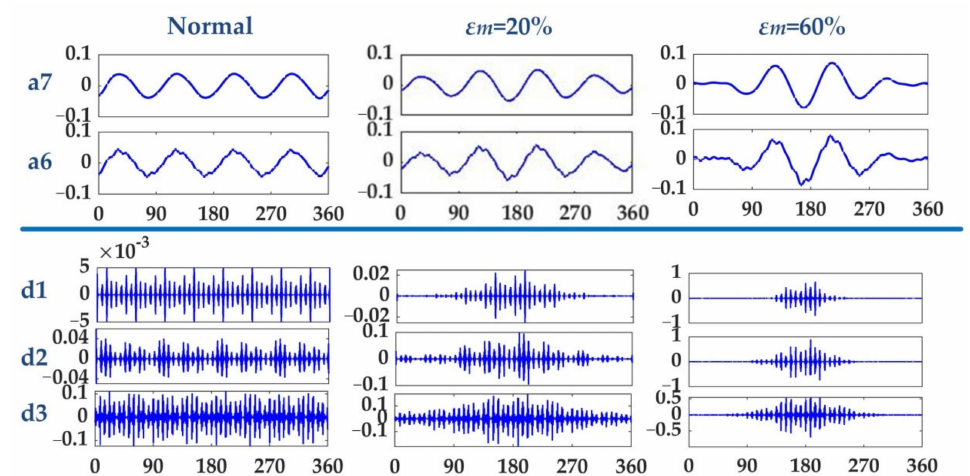
Figure 8. The results of wavelet decomposition of tangential air-gap flux